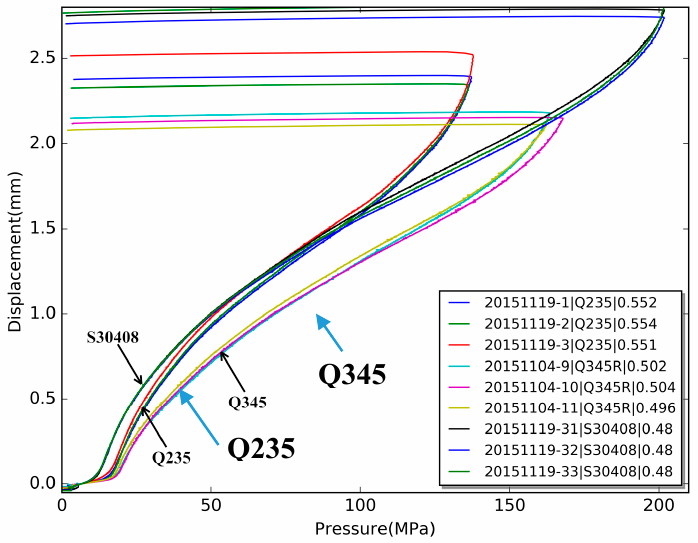
Figure 4. Pressure-displacement curves of hydraulic bulge test (HBT).